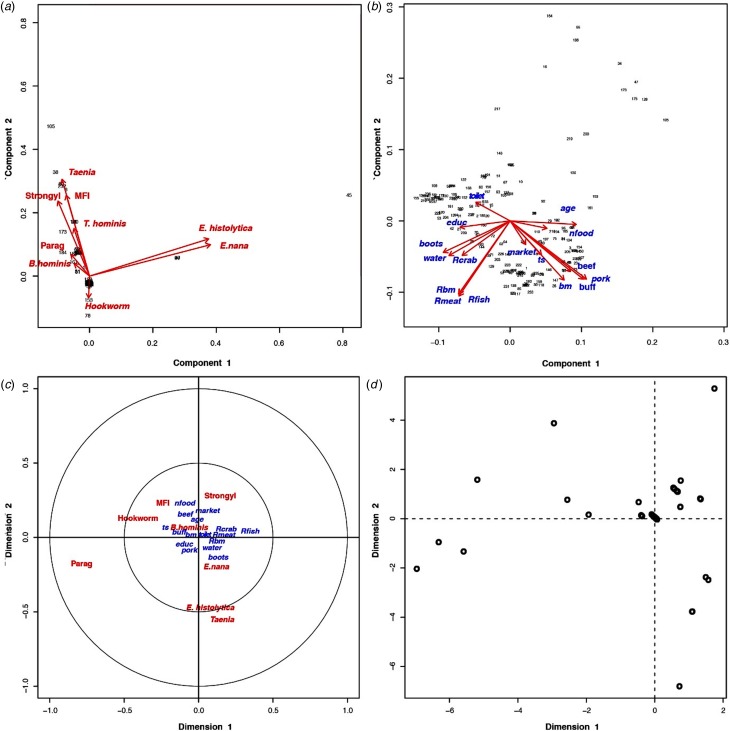
(a) Principal component analysis of parasites and their distribution among the inhabitants of Huay Muang, with the two first axes of the PCA explaining 31.3% of the variance. (b) Principal component analysis of the socio-demography and perceptions distribution among the inhabitants of Huay Muang, with the two first axes of the PCA explaining 45.9% of the variance. (c) Biplot graph of canonical correspondence analysis showing the association between intestinal parasites in relation to socio-demography (represented by PCA in (a)) and perceptions (represented by PCA in (b)) of Huay Muang villagers, with (d) the distribution of the inhabitants of Huay Muang. Rbm, raw bushmeat; Rmeat, raw meat (pork and beef); Rcrab, raw crab; Rfish, raw fish; water, water filtrated; boots, use of boots; market, food is mainly obtained from the market; ts, food is mainly obtained by the household; bm, consumption of bushmeat; pork, consumption of pork meat; buff, consumption of buffalo meat; beef, consumption of beef meet; nfood, consumption of natural food; toilet, presence of toilets; educ, level of education (from none to technical college); age, age; Strongyl, Strongyloides sp.; Parag, Paragonimus sp.; MIF, fish-borne trematodes.